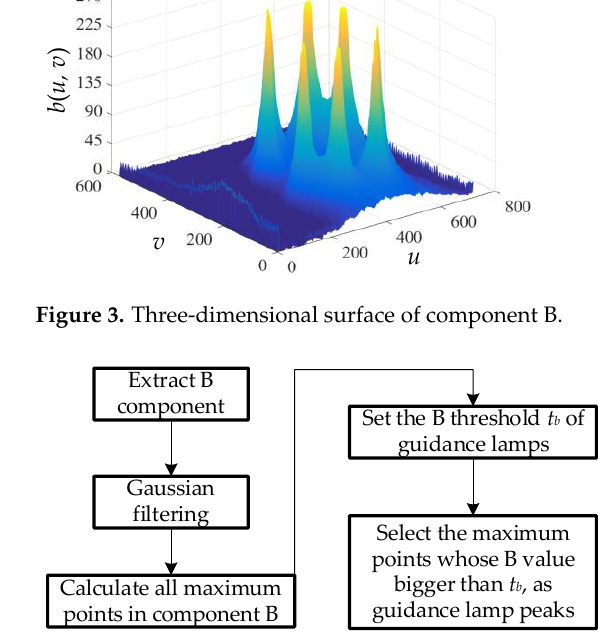
Figure 4. Extraction process of guidance lamp peaks.